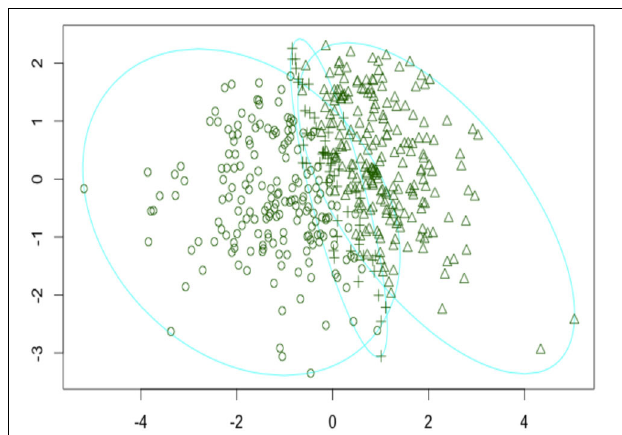
FIGURE 1 | Visual representation of the 3 cluster fuzzy clustering solution. Axes are standardized representations of the principal components of the cluster solution.